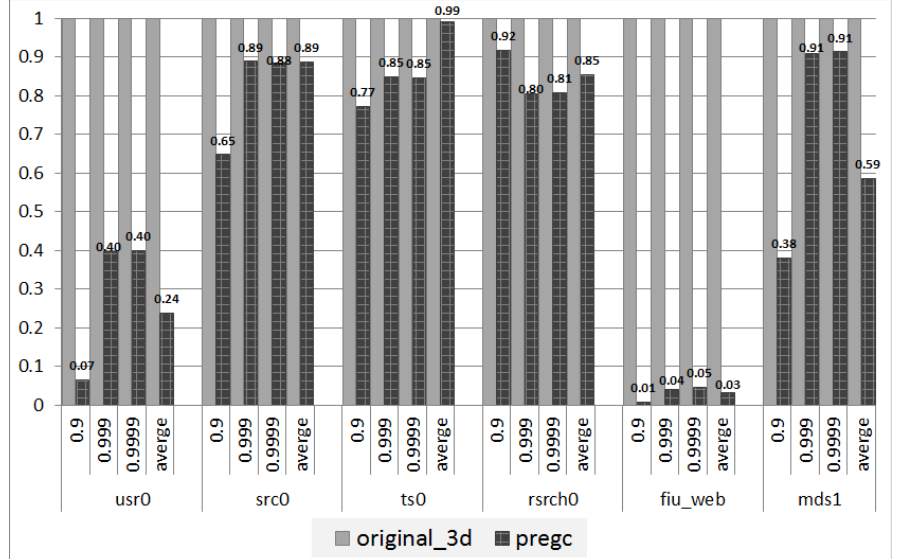
Figure 10. Comparison of tail latency related to GC. The figure shows the the normalized comparison result of the tail latancy of requests that may be affected by GC in original 3D SSDs and 3D SSDs with PreGC. Among them, based on the results of original 3D SSDs, the request tail latency of 2D SSDs is 50% less than that of 3D SSDs with PreGC on average.